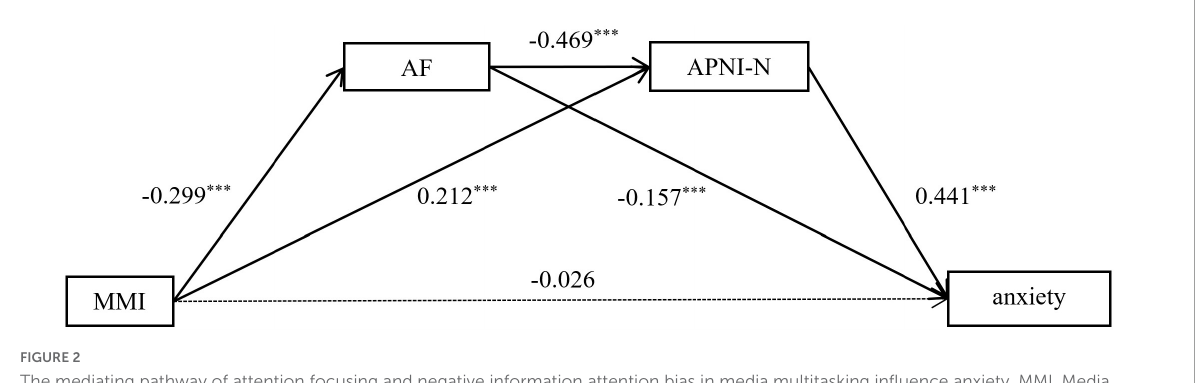
FIGURE2 The mediating pathway of attention focusing and negative information attention bias in media multitasking influence anxiety. MMI, Media Multitasking Inventory; AF, Attention Focusing dimension of Attentional Control Scale; APNI-N, Negative dimension of the Attention to Positive and Negative Information Scale. ∗∗∗ p < 0.001.